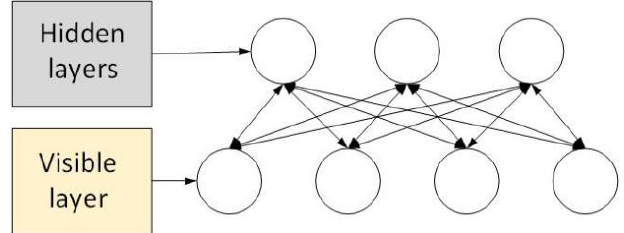
Figure 2. RBM structure schematic diagram.